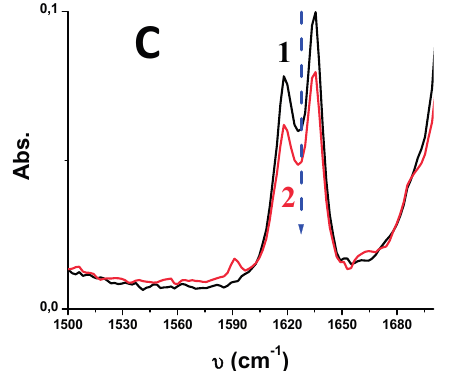
Figure 1. ( A ) Role of the atmosphere in the free radical polymerization of TMPTA in the presence of DPSi/AgSbF 6 (2%/1% w/w ): ( 1 ) under air and ( 2 ) under argon; ( B ) IR band of the decreasing of the DPSi recorded during the polymerization; and ( C ) real-time FT-IR spectra in the 1600–1670 cm − 1 wavenumber range of sample containing 1% (wt) of AgSbF 6 and 2% (wt) of DPSi in TMPTA under air ( 1 - before and 2 - after polymerization).